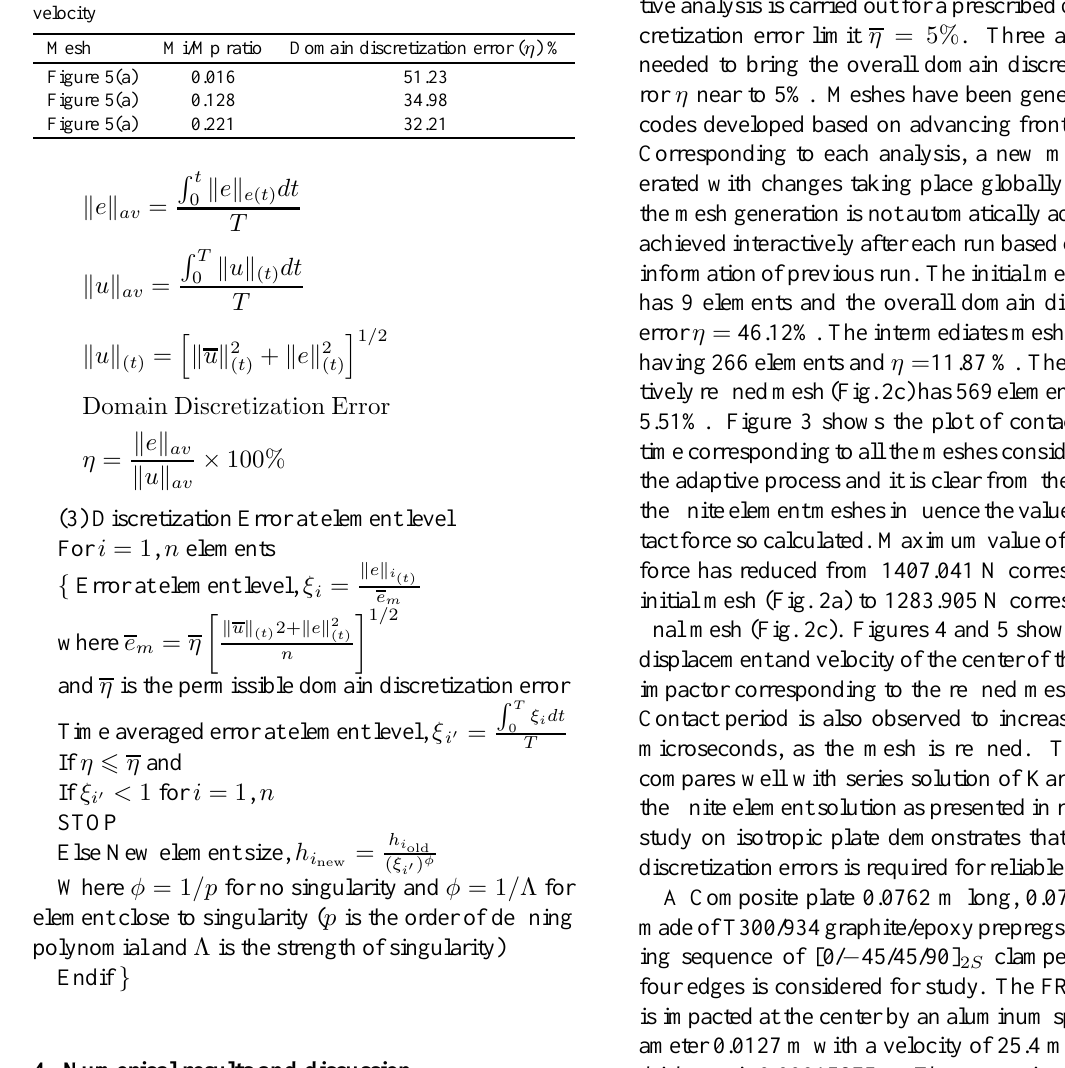
Table 3 Discretization error for varying Mi/Mp ratio with constant